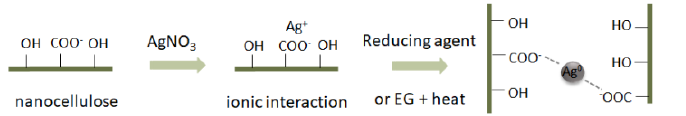
Figure 2. Scheme to show the interactions between Ag NPs and NC during the synthetic procedure.